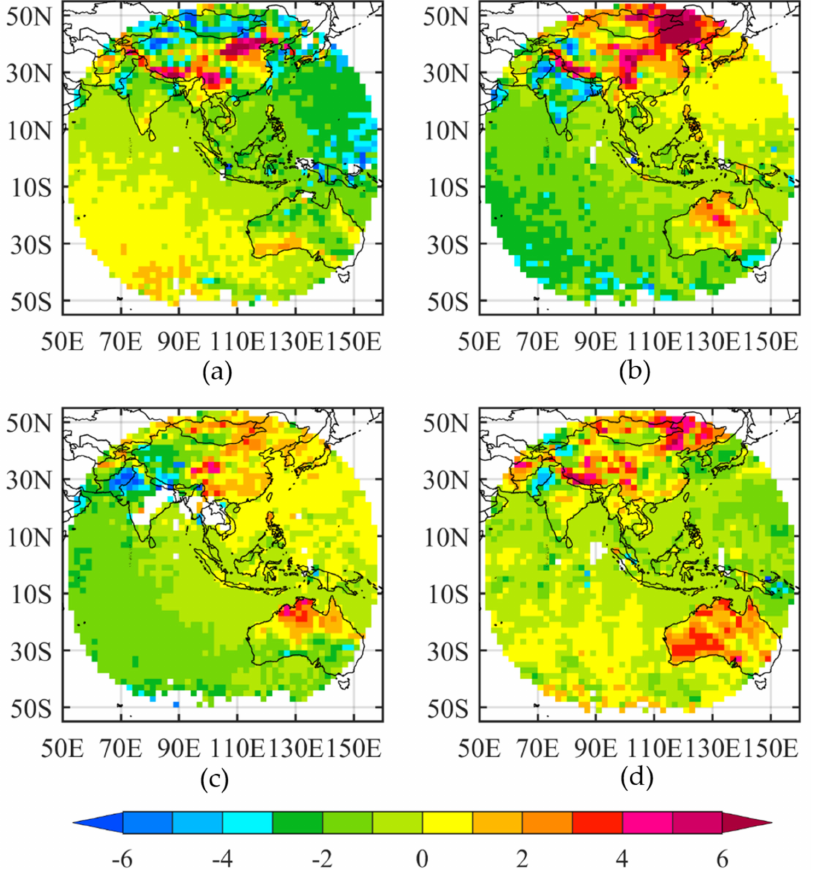
Figure 8. Spatial distributions of OMB FNL biases for AGRI band 11 calculated within each 2 ◦ × 2 ◦ grid box in ( a ) January, ( b ) April, ( c ) July, and ( d ) October 2019, respectively. (Unit: K).